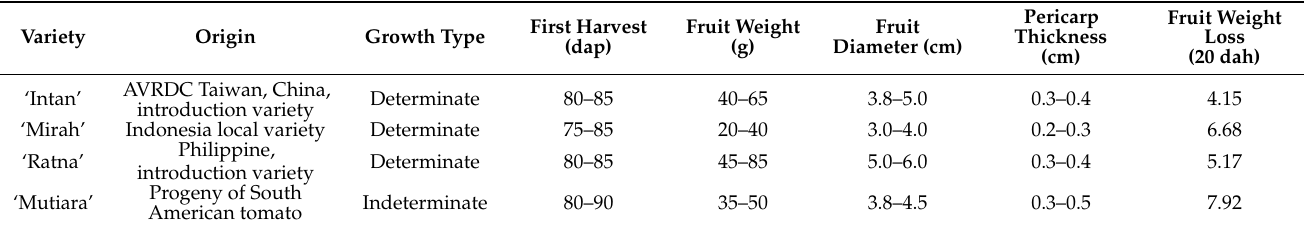
Table 1. Description of four tropical tomato cultivars (female parents/